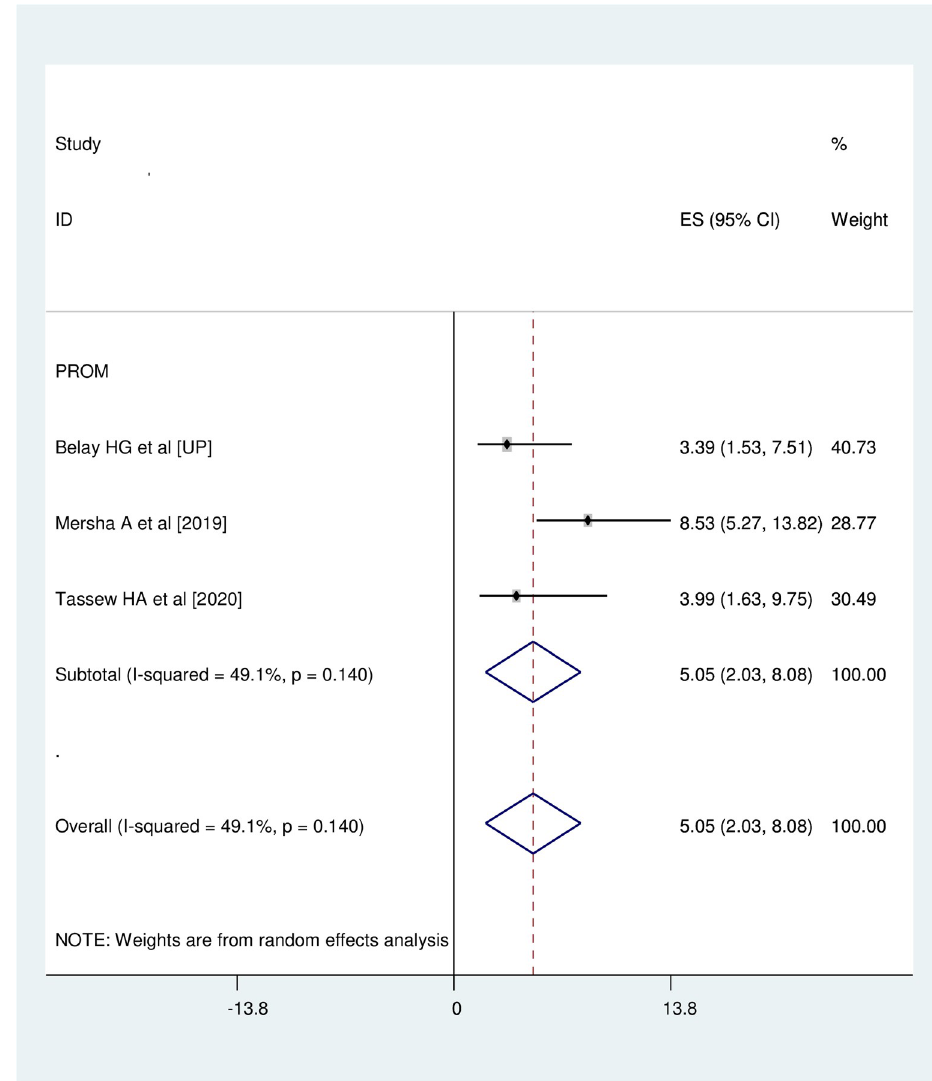
Fig 6. Association between premature rupture of membrane (PROM) and neonatal near